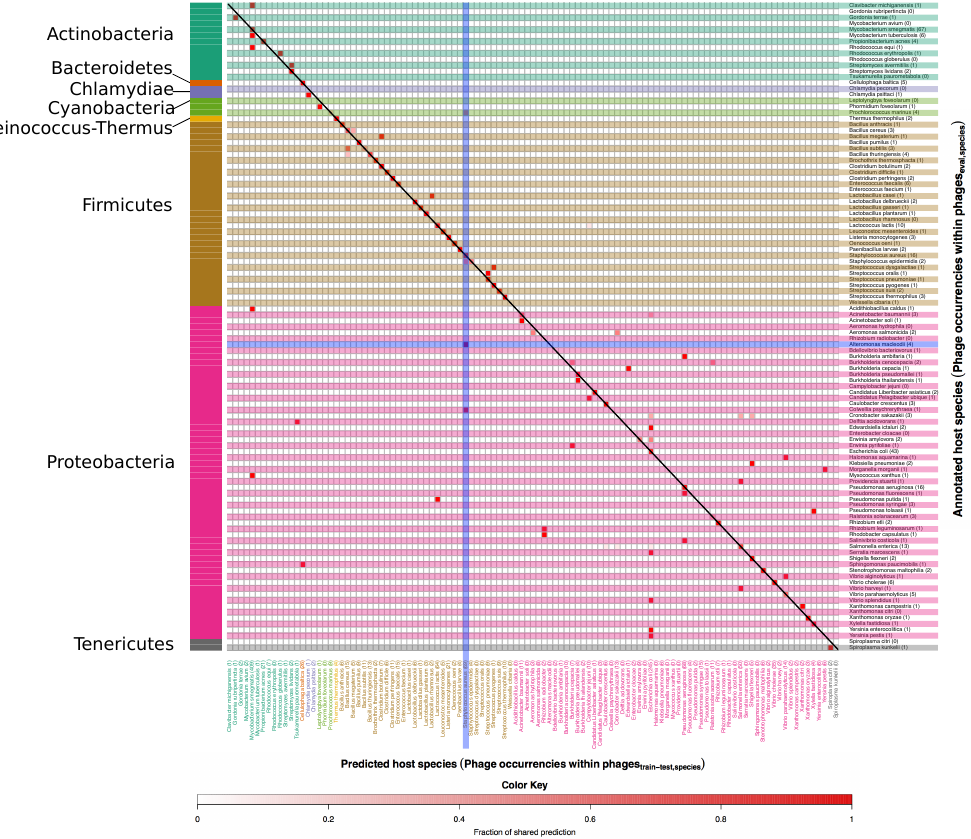
Figure 6. Heatmap of annotated vs. predicted host species in the phages set. In this figure eval,species correct as well as mispredicted host species can be seen. Annotated host species are listed along the y axis, while predicted ones are on the x axis. The number after each species on the y axis and the x axis also indicate the occurrences of phages in the phage and in the phages respectively. eval,species train-test Host species are grouped according to the respective phylum, which are indicated on the left side of the figure. The colour scale indicates the fraction of phages predicted as targeting a particular host and goes from white, no phages, to red, 100% of the phages. Accordingly, the colour itself is not an indicator of correctness of the prediction, and red colours along the diagonal represent correct